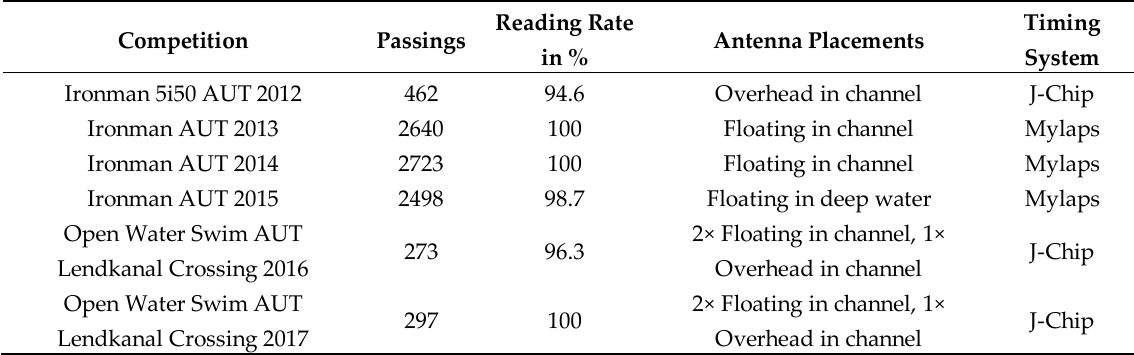
Table 3. Measurement results of the reading rate during different swimming competitions of past